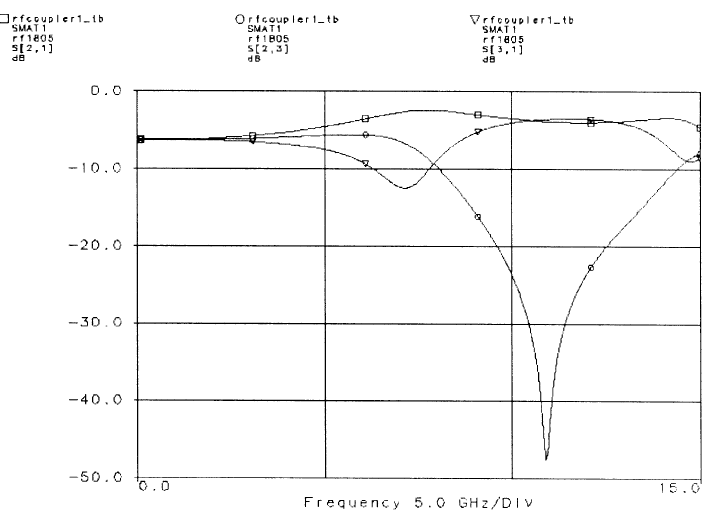
FIGURE 22 Transmission coefficients ( j s 21 j and j s 31 j ) and isolation ( j s 23 j ) between the output